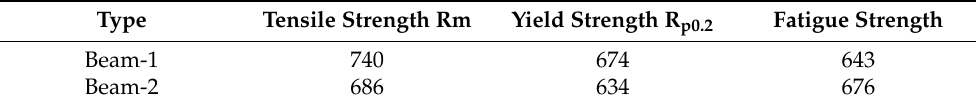
Table 2. Mechanical properties and fatigue strength of Beam-1 and Beam-2 steels (MPa). Type Tensile Strength Rm Yield Strength R p0.2 Fatigue Strength Beam-1 740 674 643 Beam-2 686 634 676